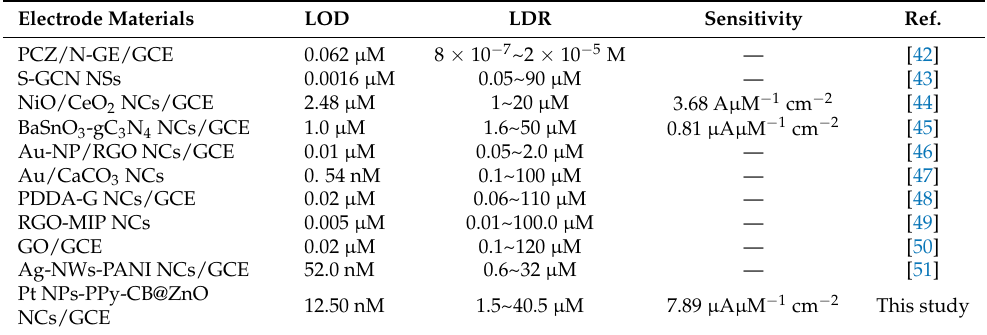
Figure 11. ( a ) The DPV investigation of 4 − NP analysis at distinct pH value of buffer medium, ( b ) DPV analysis of various toxic chemicals in 16.5 µ M concentration, ( c ) the repeatability performance of 4 − NP sensor at 4.5 µ M concentration of 4 − NP I buffer medium of pH 7.0, and ( d ) interference effects of 4 − NP sensor probe. Table 1. Comparison of sensor performances with various modified electrode towards the detection of 4-NP by an electrochemical